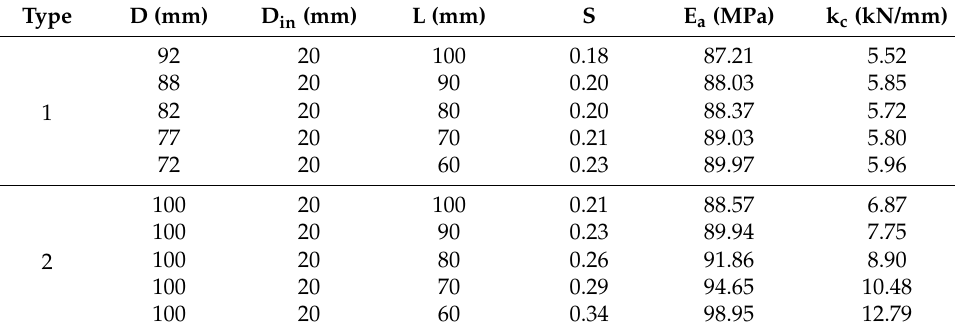
Table 1. Properties of experimental